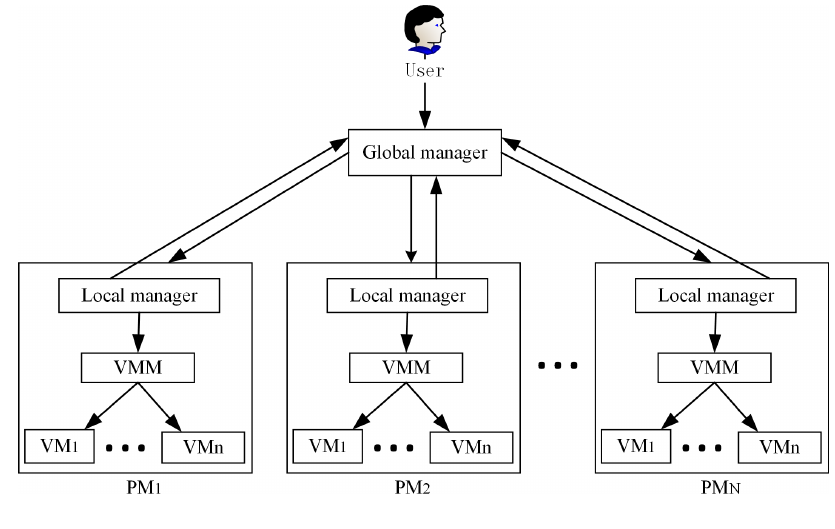
Figure 2. The system